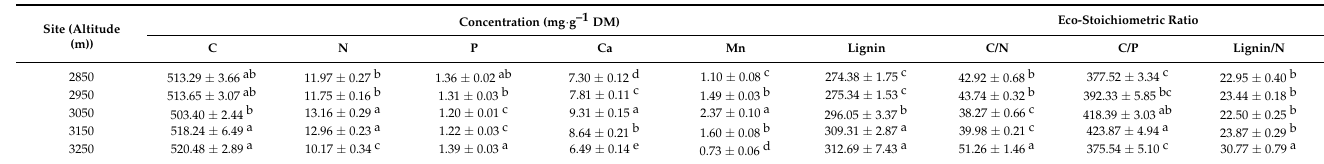
Table 1. Initial chemical composition of leaf litter (mg · g − 1 dry mass (DM)) for each Qinghai spruce site (mean ± SE, level =